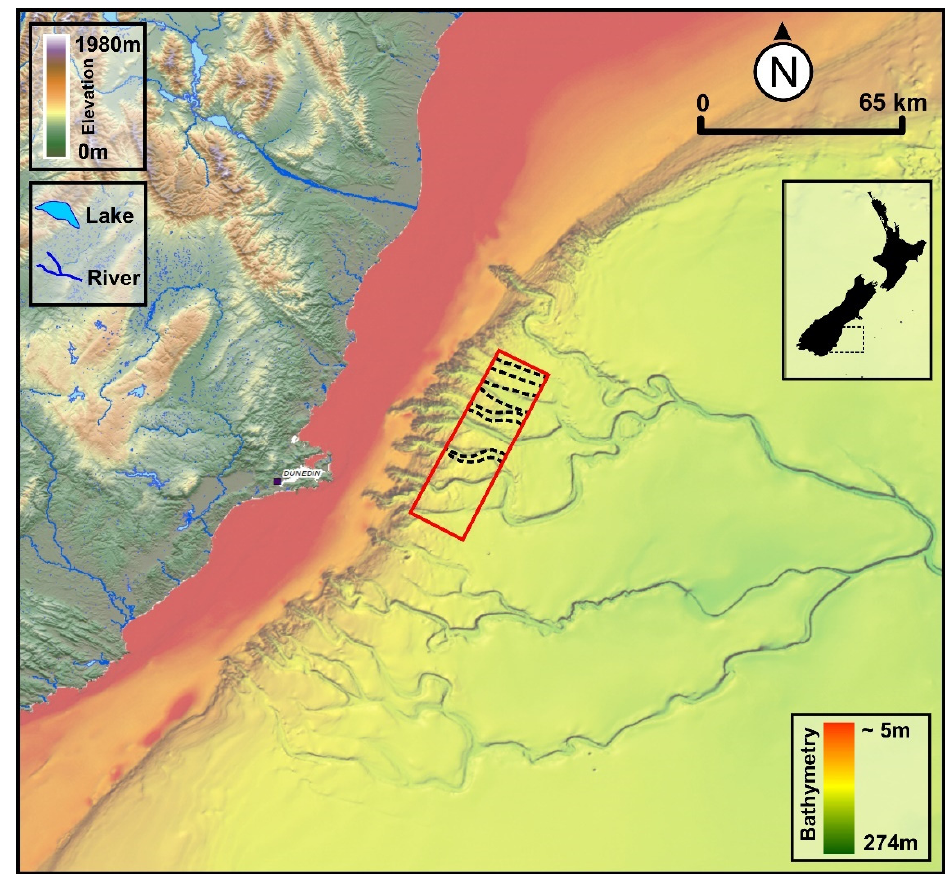
Figure 10. Recent New Zealand elevation and bathymetry (Source: NIWA Open Data License v1.0). Red rectangle is the study area that located in a marine environment (Continental shelf). See Figure 1a for coordinate location.